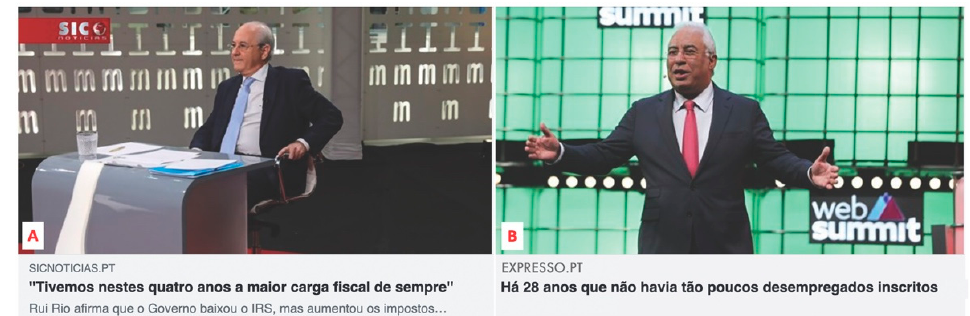
Figure 2 . Example of real news pro-right ( A ) and pro-left ( B ) used in the study. Note: A —The past enrolled for 28 years. Source: Image A was adapted from https://bit.ly/3hSg3PS (accessed on 25 May 2021). Image B was adapted from https://bit.ly/3aIsfhb (accessed on 25 May 2021).